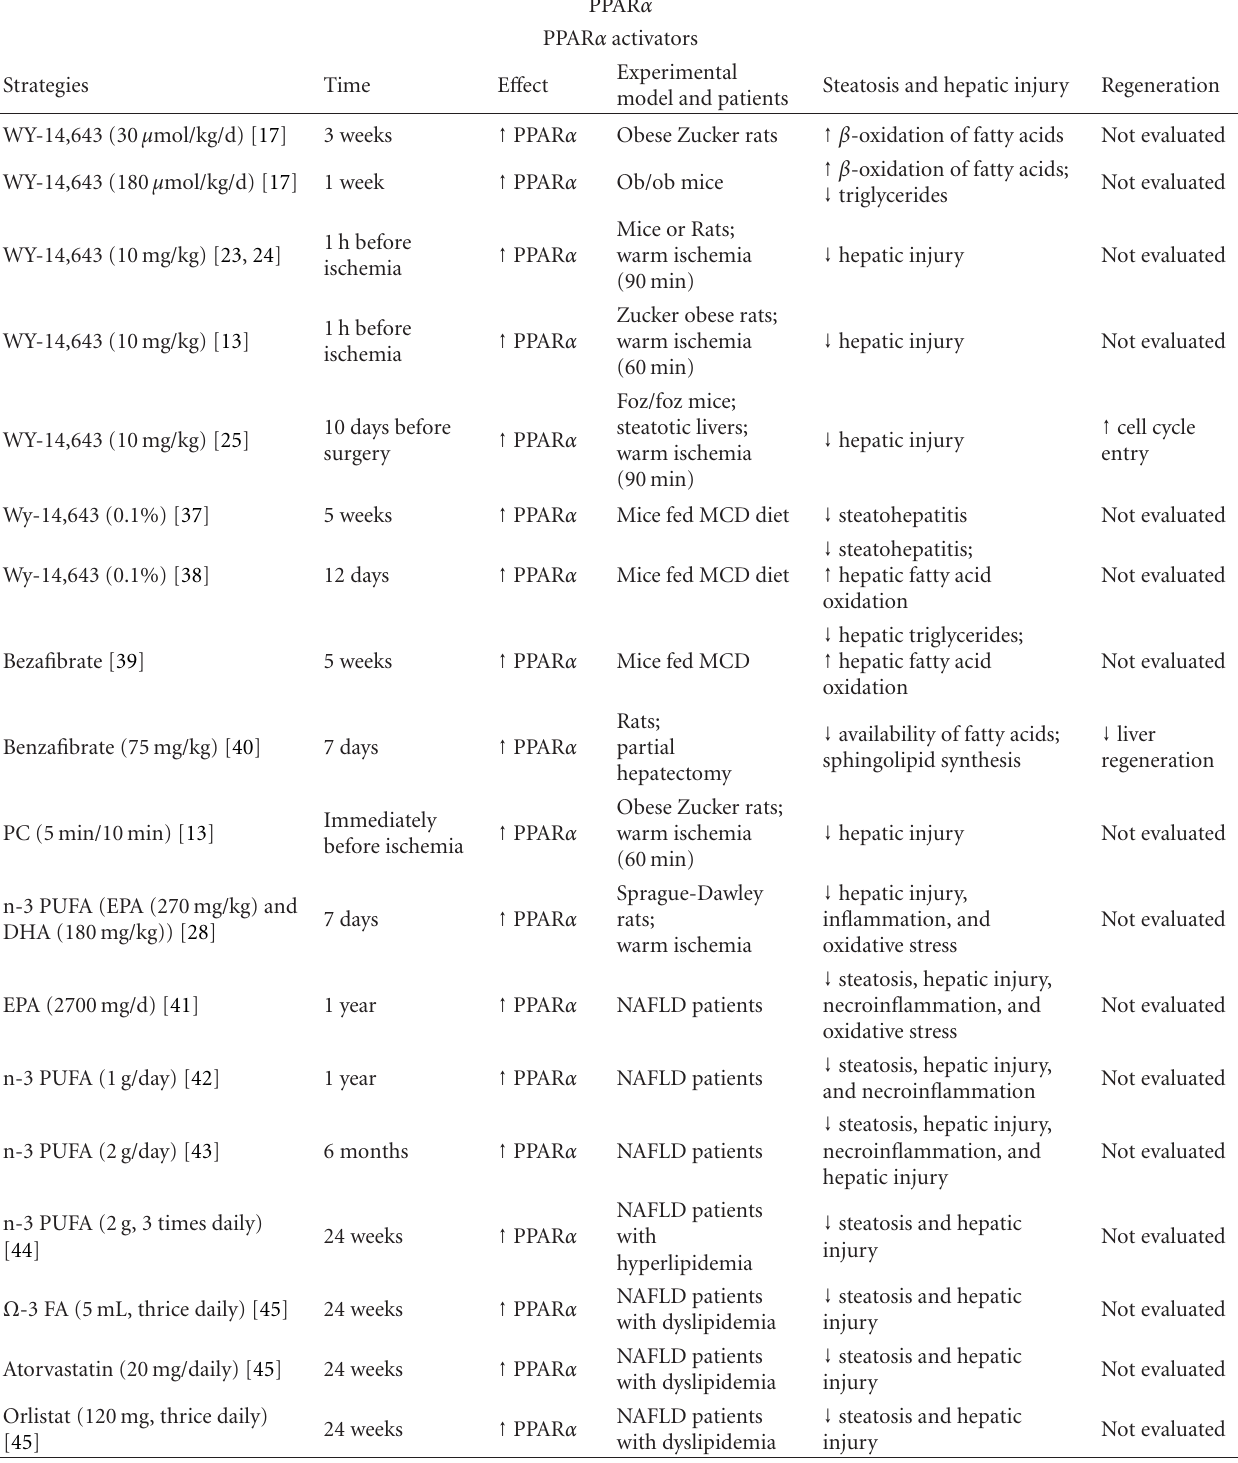
Table 1: E ff ect of strategies that regulate PPAR on hepatic injury, steatosis, and regeneration in experimental models and patients. Angiot- ensin II: Ang II; choline deficient: CD; epidermal growth factor: EGF; high-fat diet: HFD; insulin-like growth factor 1: IGF-1; methionine choline deficient: MCD; nonalcoholic Steatohepatitis: NASH; peroxisome proliferator-activated receptors: PPARs; polyunsaturated fatty acids: PUFAs; ischemic preconditioning: PC; retinol binding protein-4: